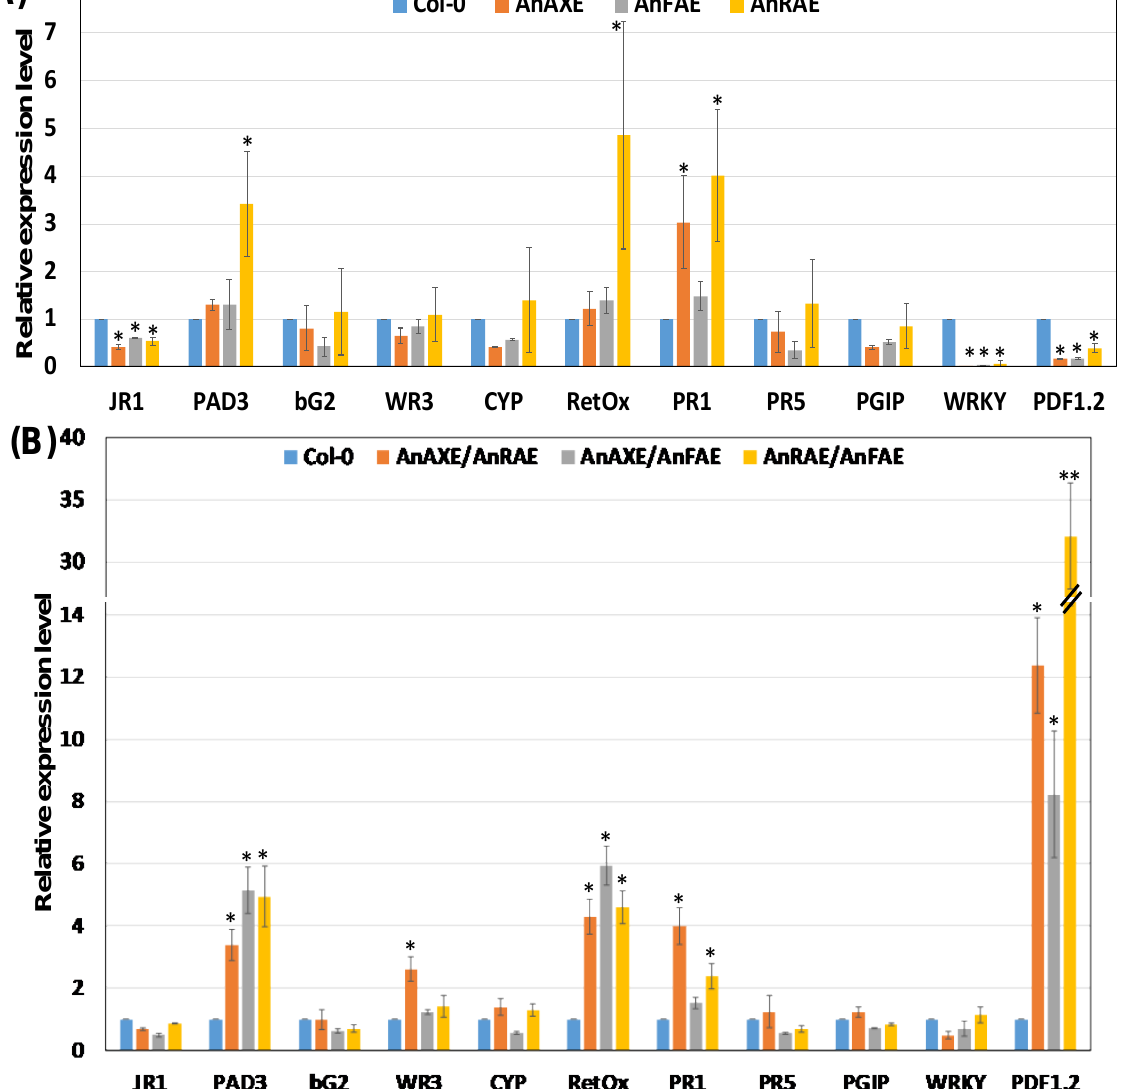
Figure 4. Overexpression of acetyesterases and feruloylesterase trigger pathogen-responsive gene expression. RT-qPCR analysis was conducted to find out the transcript level of defense pathway genes in six different uninfected healthy transgenic lines: ( A ) Transcript level of single gene overexpressor plants (AnAXE, AnRAE, and AnFAE); ( B ) Transcript level of double gene overexpressor plants (AnAXE/AnRAE, AnAXE/AnFAE and AnRAE/AnFAE). Three-week-old uninfected healthy seedlings were subjected to transcript analysis. ACTIN2 was used as reference gene to normalize the data [37,61]. The transcript data represents average ± SD of three different independent transgenic lines for each construct and WT plant. Asterisks indicate significant differences among the transgenic plants and WT plants (Student’s t test, * p < 0.05; ** p < 0.01).